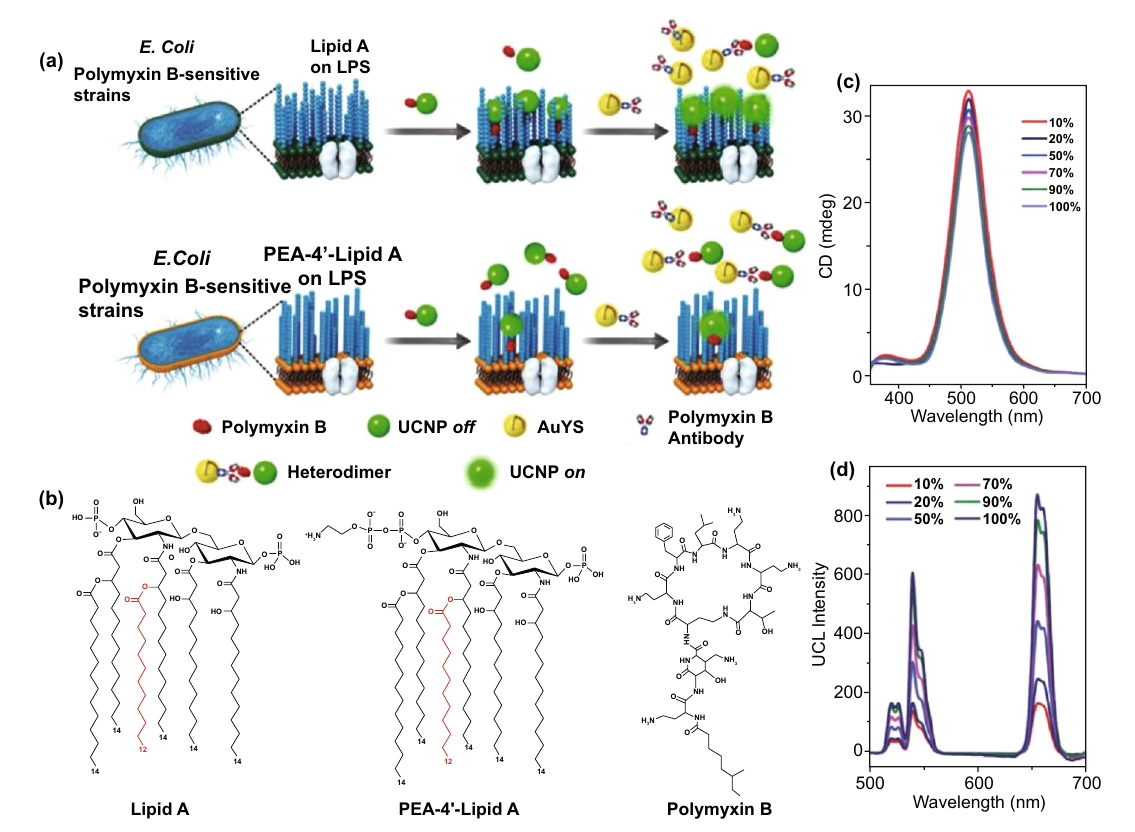
Fig. 4 Chiral upconversion Au YS-UCNP heterodimers for the quantitative analysis and bioimaging of polymyxin B-resistant bacteria in vivo. a Schematic mechanism of Au YS-UCNP heterodimers for detecting polymyxin B-resistant bacteria. b Chemical structure of lipid A (from polymyxin B-sensitive strains), PEA-4 ′ -lipid A (from polymyxin B-resistant strains) and polymyxin B. c, d The CD signal ( c ) and UCL intensity ( d ) of the Au YS-UCNP heterodimer after incubation with different ratios of polymyxin B-resistant bacteria and polymyxin B-sensitive strains. Reproduced with permission from Ref. [134]. Copyright 2018 John Wiley and Sons,